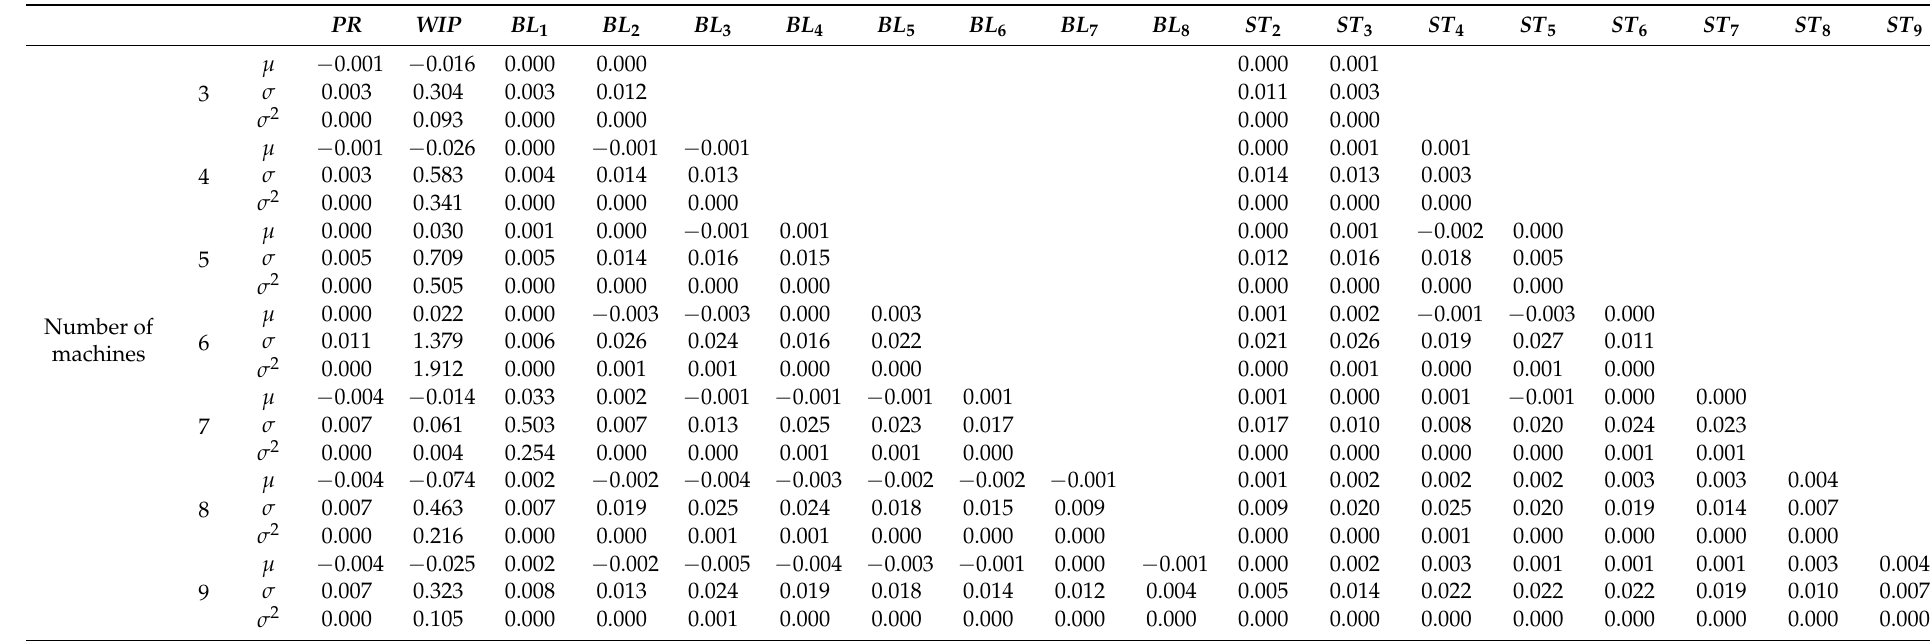
Table 1. Aggregation procedure: mean value, standard deviation, and variance of the relative error concerning the analytical